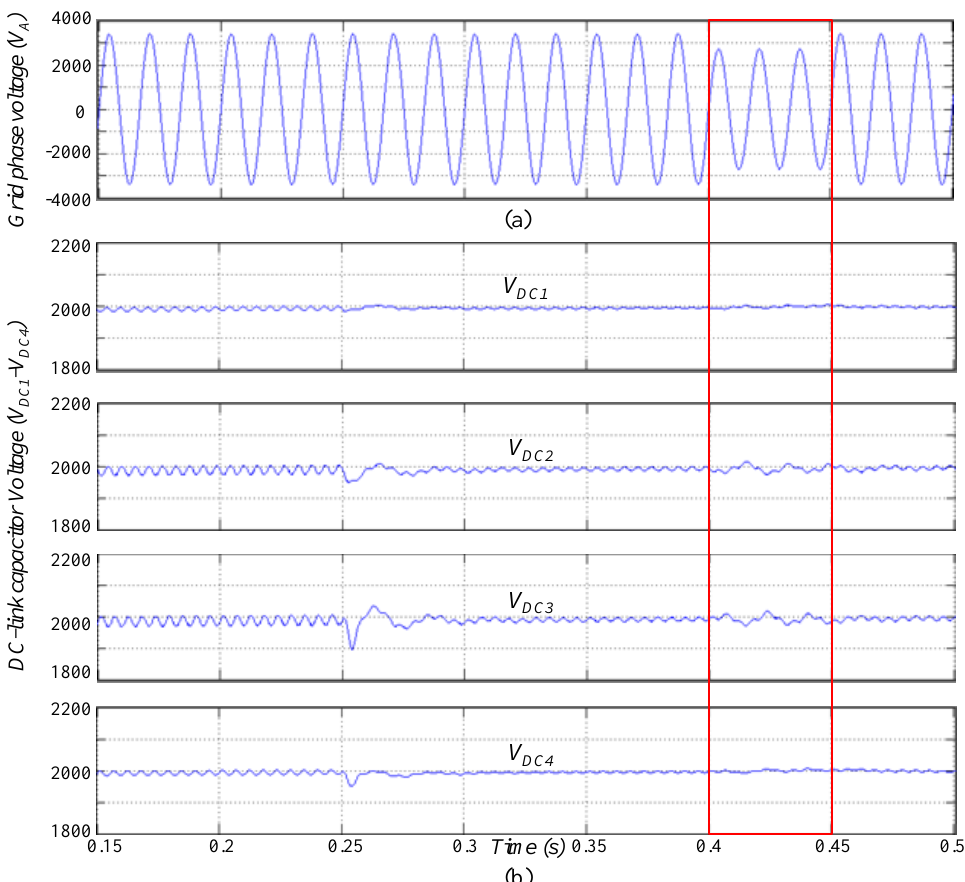
Figure 12. Simulation waveforms of the proposed five-level STATCOM under voltage sag condition. ( a ) Phase output voltage ( V AN ) for Phase A; ( b ) DC-link capacitor voltages ( V DC 1 - V DC 4 ).